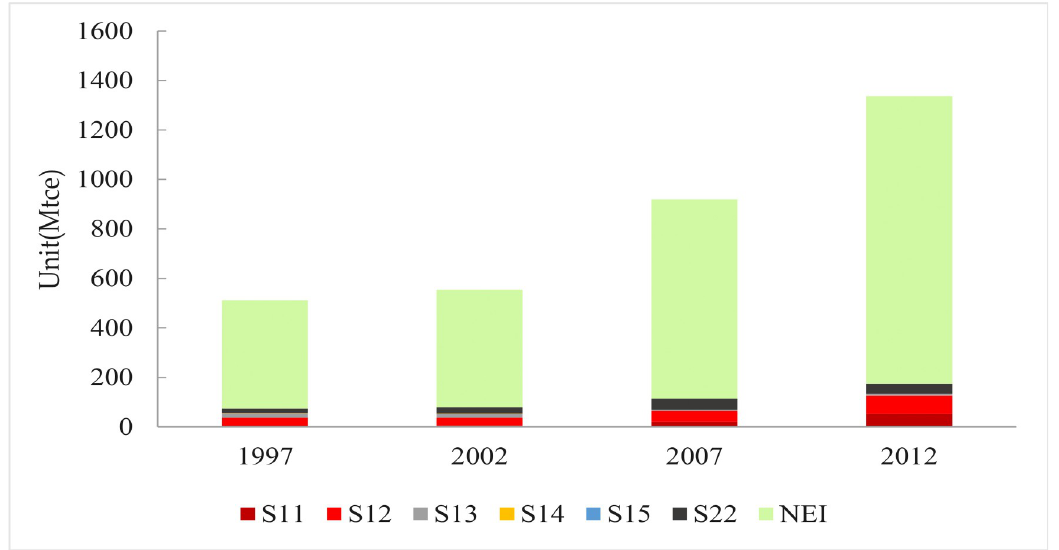
Fig 3. Chinese sectoral household indirect energy consumption in 1997, 2002, 2007, and